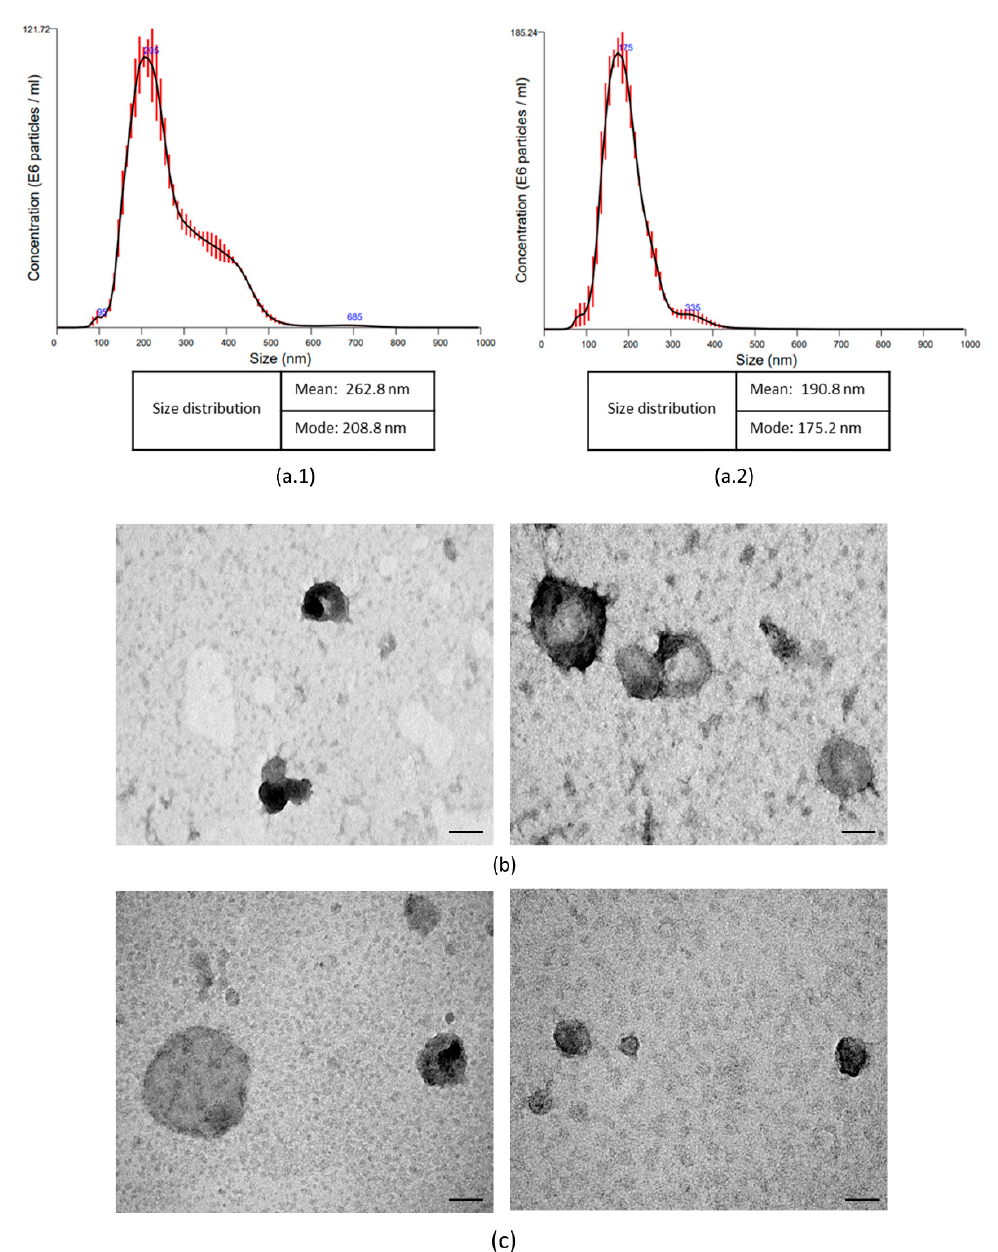
Figure 3. Characterization of extracellular vesicles derived from MSCs and expanded CD133 + cells. Graph A represents the distribution of extracellular vesicle sizes, as determined by NTA. ( a.1 ) The size distribution of EVs derived from MSCs, and ( a.2 ) the size distribution of expanded CD133 + cells. ( b ) Representative transmission electron microscopy (TEM) image of EVs derived from MSCs hUCT and ( c ) representative TEM image of extracellular vesicles derived from CD133 + hUCB-derived. Scale bar: 200 µm.